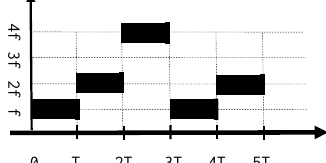
Figure 9: Time Hopping-Direct Sequence Spread Spectrum